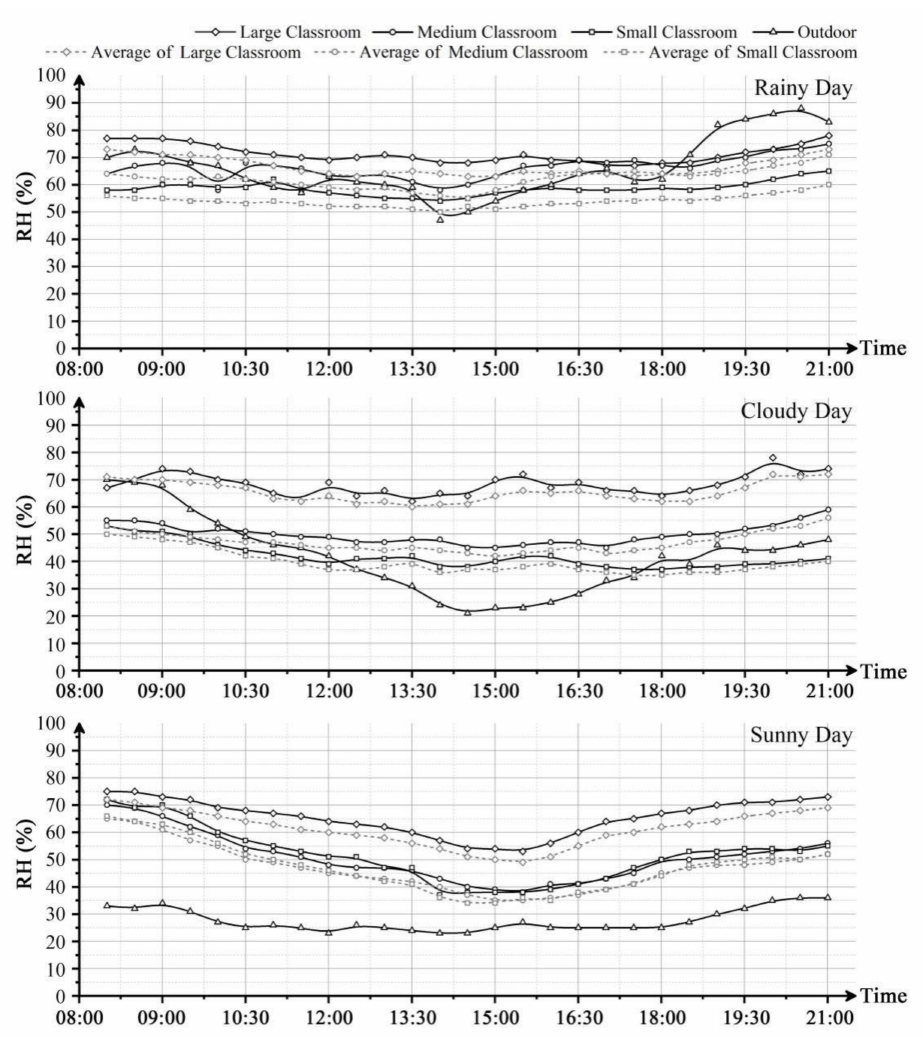
Figure 8. Humidity in the three classroom-types under different weather conditions throughout the